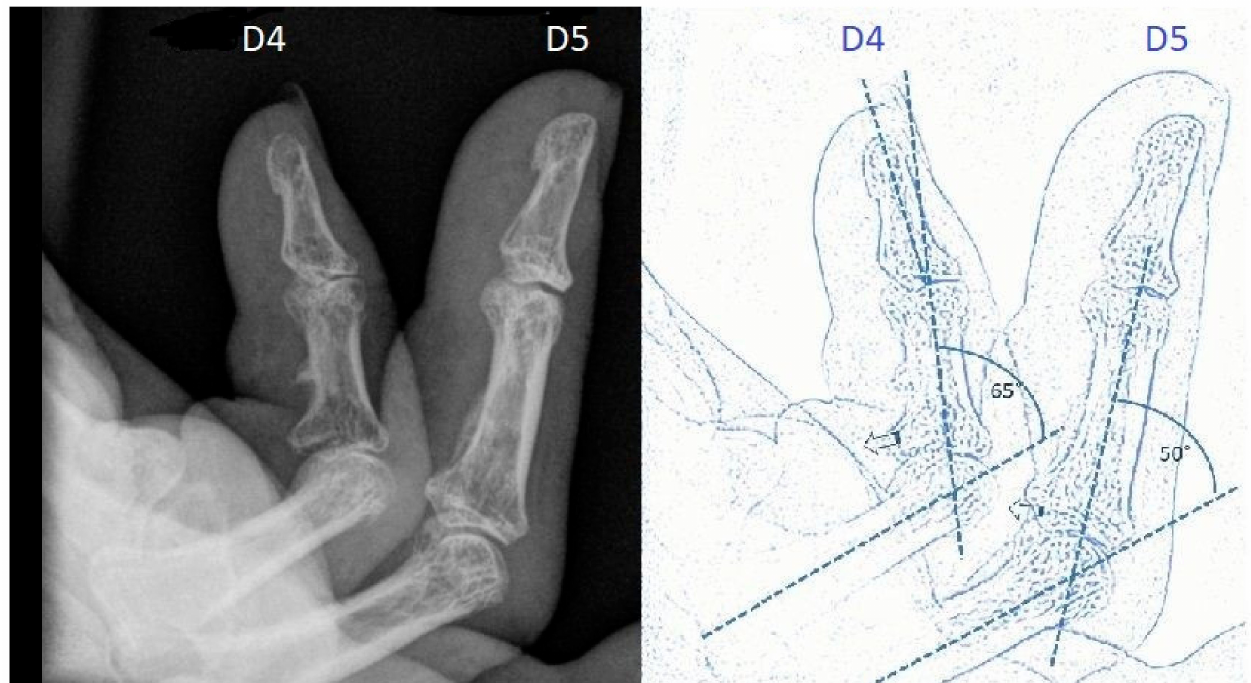
Figure 6. Preoperative X-ray of stage IV flexion deformity and schematic drawing.